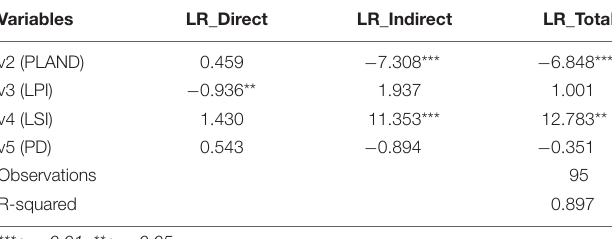
TABLE 5 | Estimating results of eco-geographical zoning.